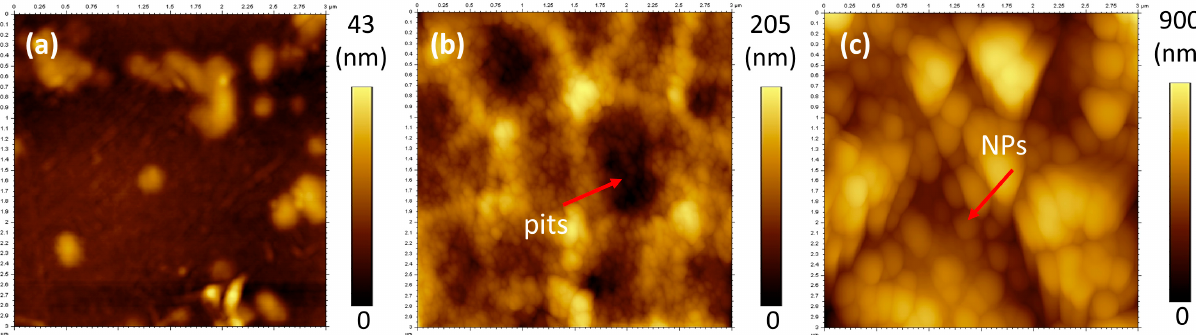
Figure 3. AFM images of PET surfaces—( a ) PET untreated, ( b ) PET hydrolysed, ( c ) PET NP.